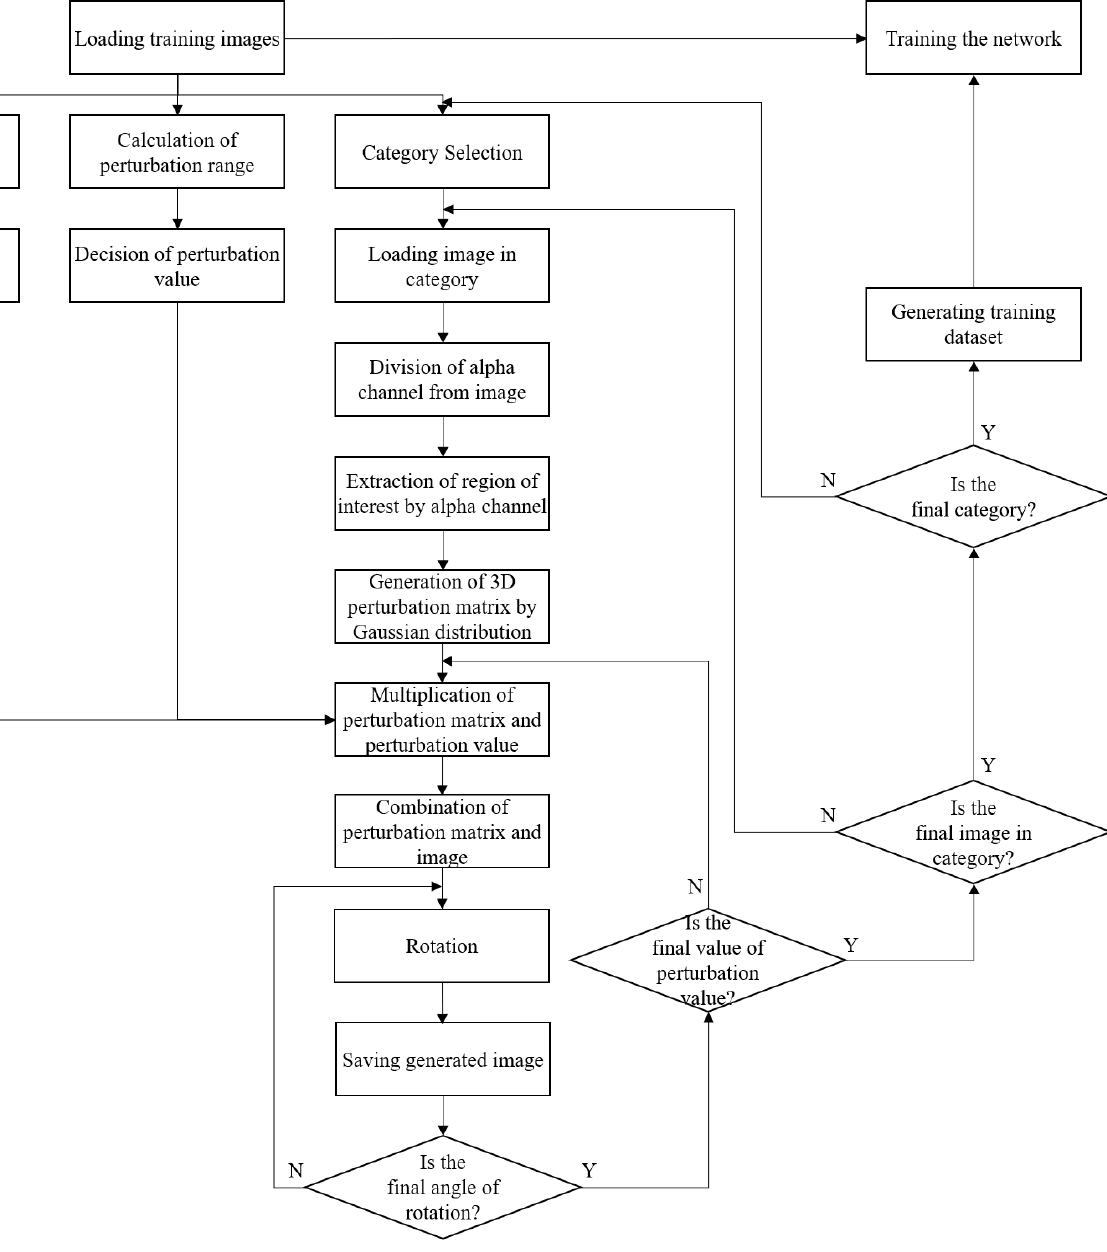
Figure 2. Overview of the proposed